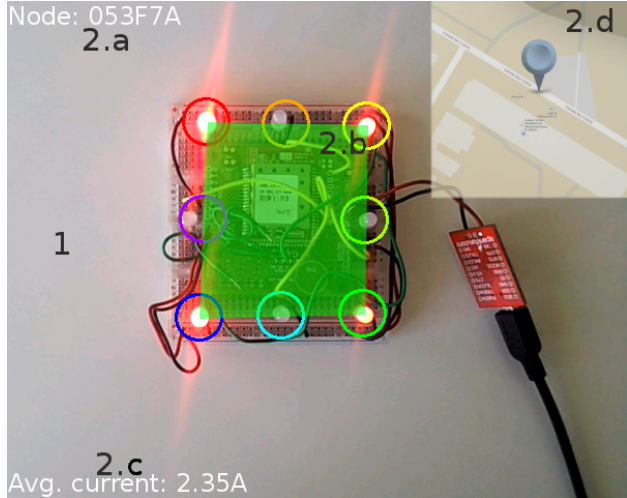
Figure 11. Information presented to the user via the AR